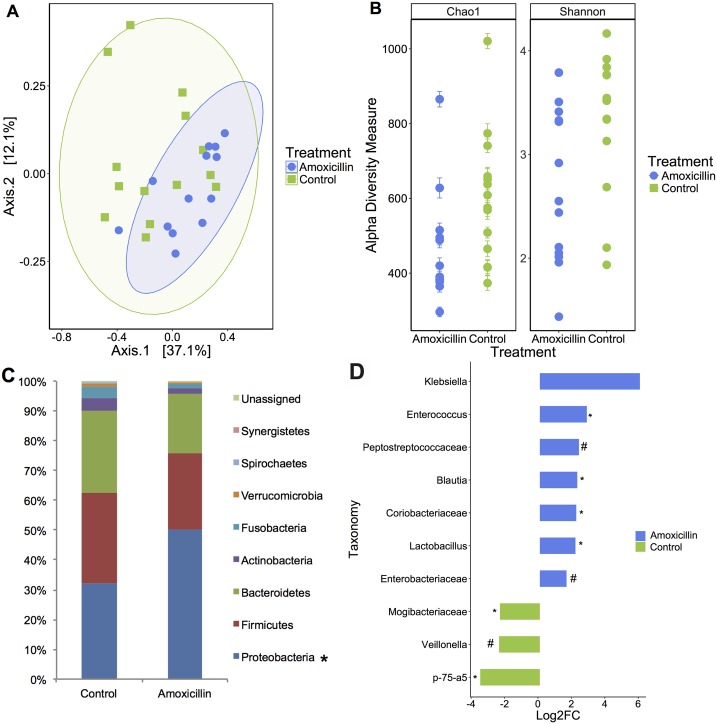
Amoxicillin treatment influenced gut-associated microbial composition, as displayed by distinct clustering in the principal coordinates plot of Bray Curtis dissimilarity on day 7 (A). Each dot represents fecal microbiota of one piglet (Anosim P = 0.014). Alpha diversity was significantly reduced in piglets treated with amoxicillin on day 7 as indicated by Chao1 and Shannon index (P = 0.033 and P = 0.024, respectively, B). The stacked bar chart displays predominating phyla, calculated as a percentage of total 16S rRNA reads (C). Taxonomic differences between amoxicillin and placebo-treated piglets were identified by DeSEq2. Taxa enriched in amoxicillin are shown in blue; taxa enriched in placebo piglets are shown in green (D). (*P < 0.05; #P ≤ 0.10).